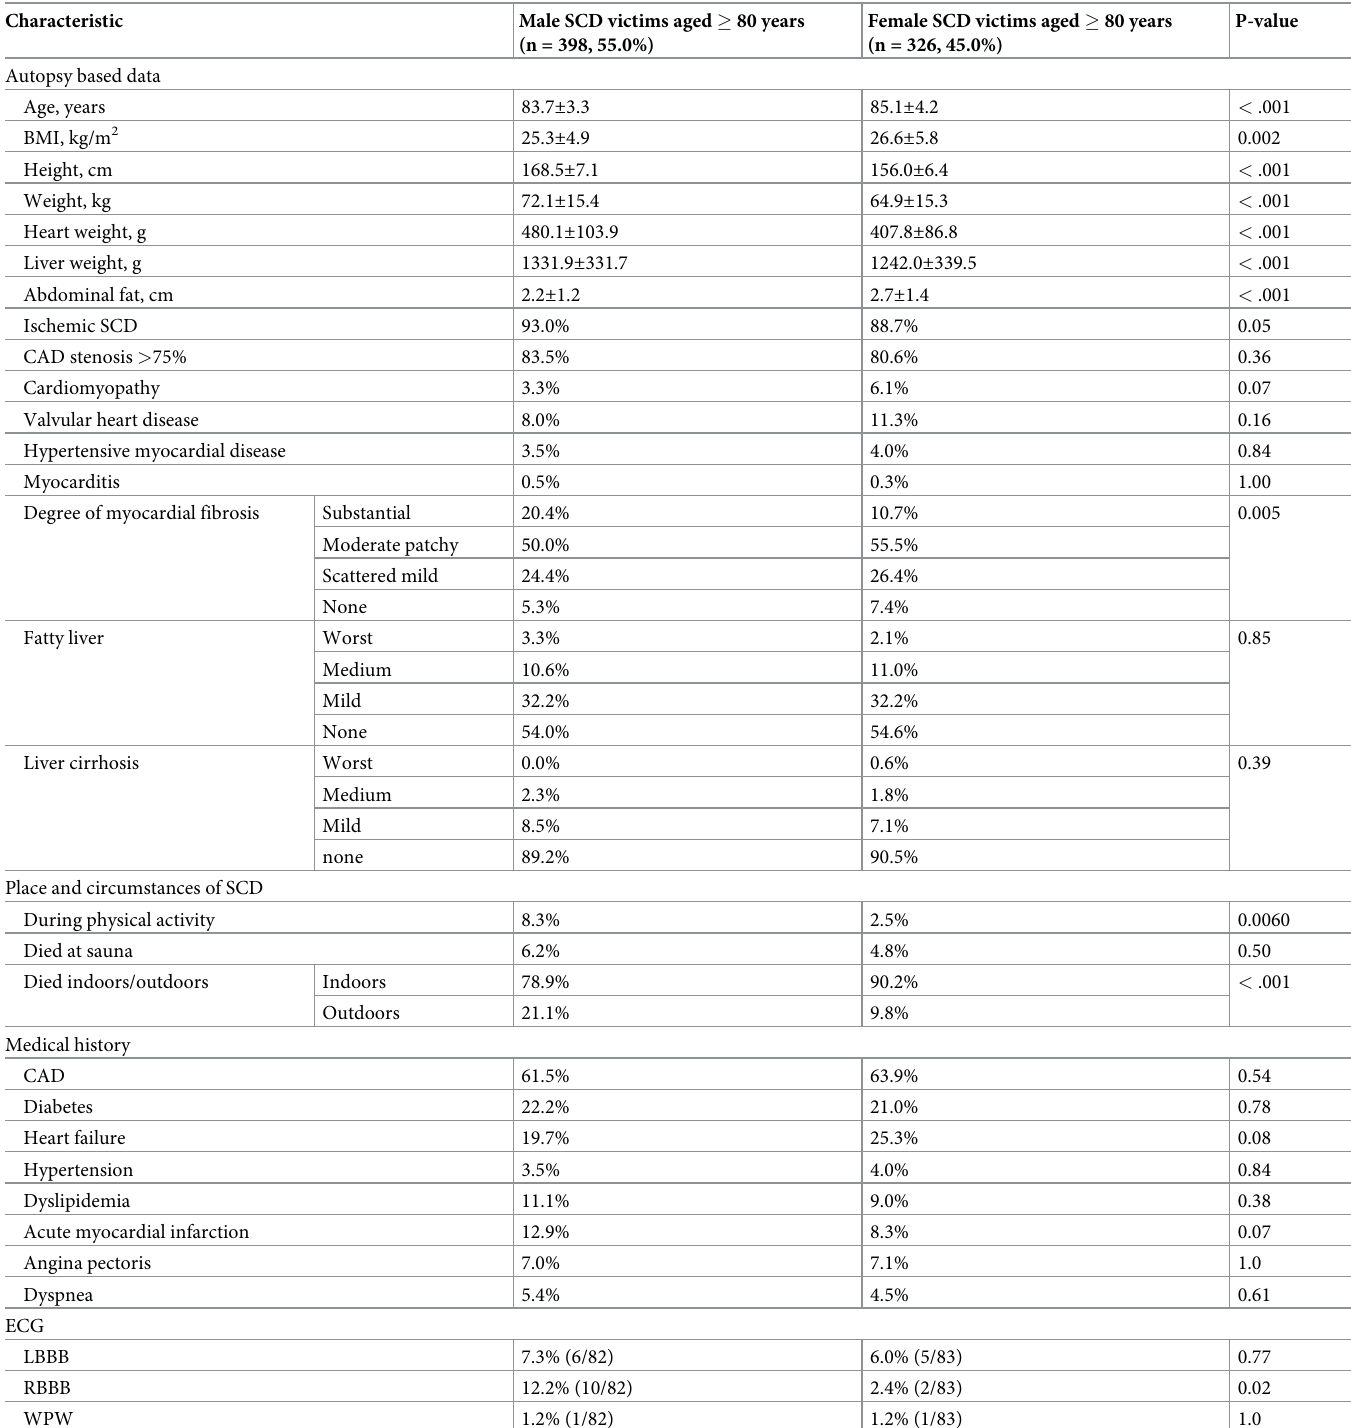
Table 3. Characteristics of male and female sudden cardiac death victims aged � 80